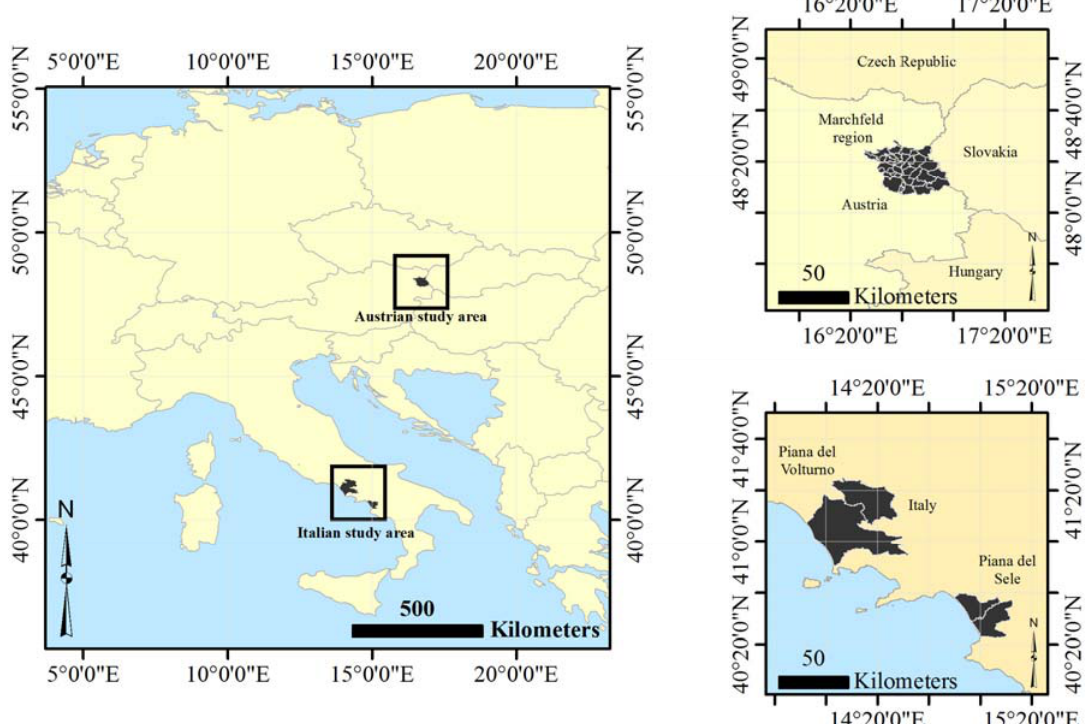
Figure 1. Selected study regions. The study was carried out in an agricultural region located in the Eastern part of Austria (‘ Marchfeld region ’) and in two areas (‘ Piana del Sele ’ and ‘ Piana del Volturno ’) located in the Campania region in Southern